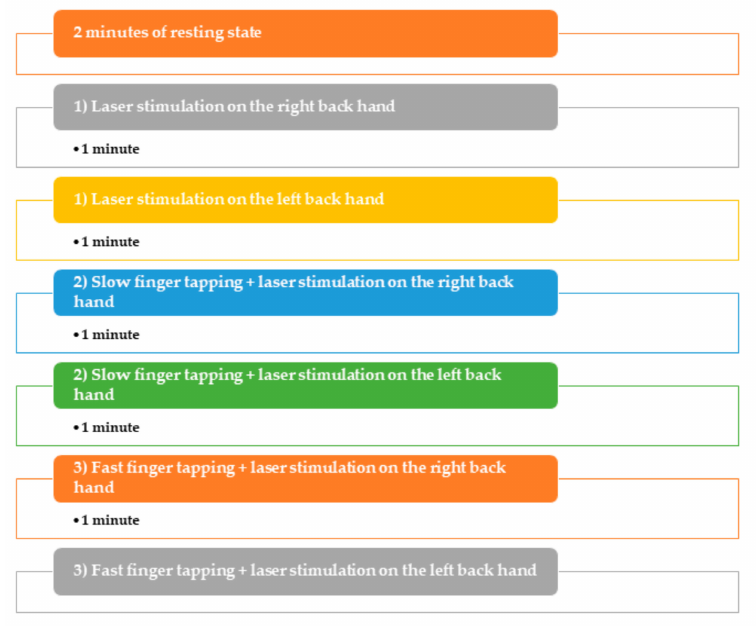
Figure 1. The randomized order of experimental